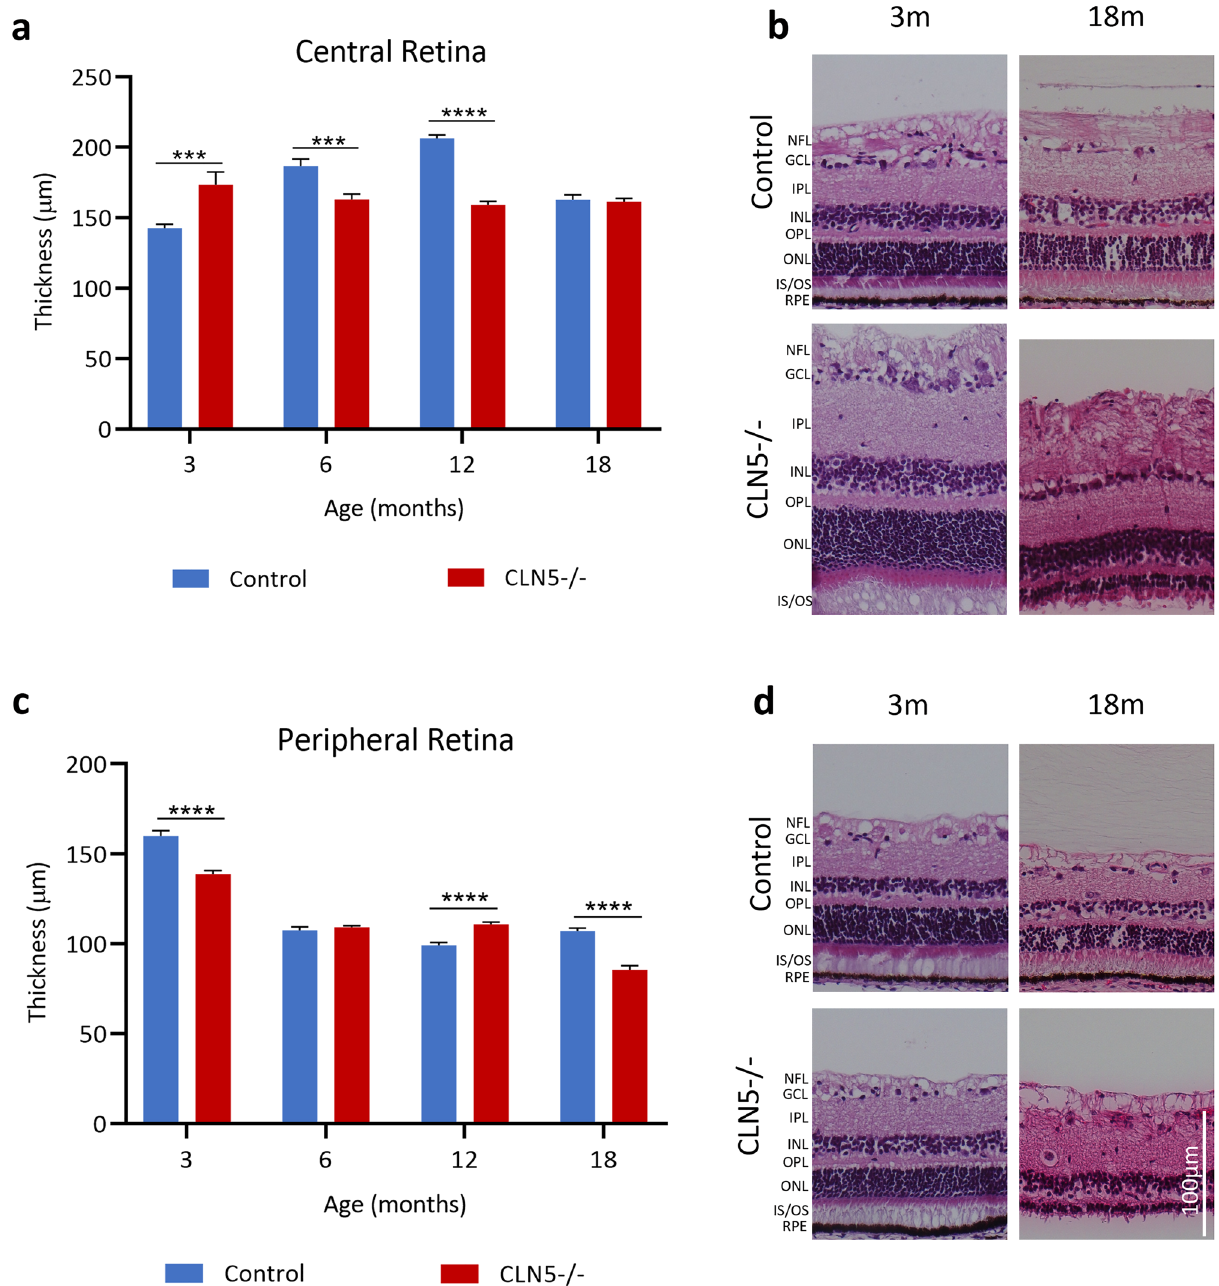
Figure 2. Total retinal thickness in healthy control and CLN5 −/− sheep at different ages. ( a ) Mean ± SEM total thickness (µm) of the central retina at 3, 6, 12, and 18 months of age in control (n = 2–4, blue) and CLN5 −/− (n = 2–4, red) sheep. ( b ) Representative images of Hematoxylin and Eosin (H + E) stained central retina in control and CLN5 −/− sheep at 3 and 18 months of age. ( c ) Mean ± SEM total thickness (µm) of the peripheral retina at 3, 6, 12, and 18 months of age in control (n = 2–4, blue) and CLN5 −/− (n = 2–4, red) sheep. ( d ) Representative images of H + E stained peripheral retina in control and CLN5 −/− sheep at 3 and 18 months of age. *** p < 0.001, **** p < 0.0001. NFL; nerve fibre layer, GCL; ganglion cell layer, IPL; inner plexiform layer, INL; inner nuclear layer, OPL; outer plexiform layer, ONL; outer nuclear layer, IS/OS; inner and outer segments of photoreceptors, RPE; retinal pigment epithelium. Scale bar 100